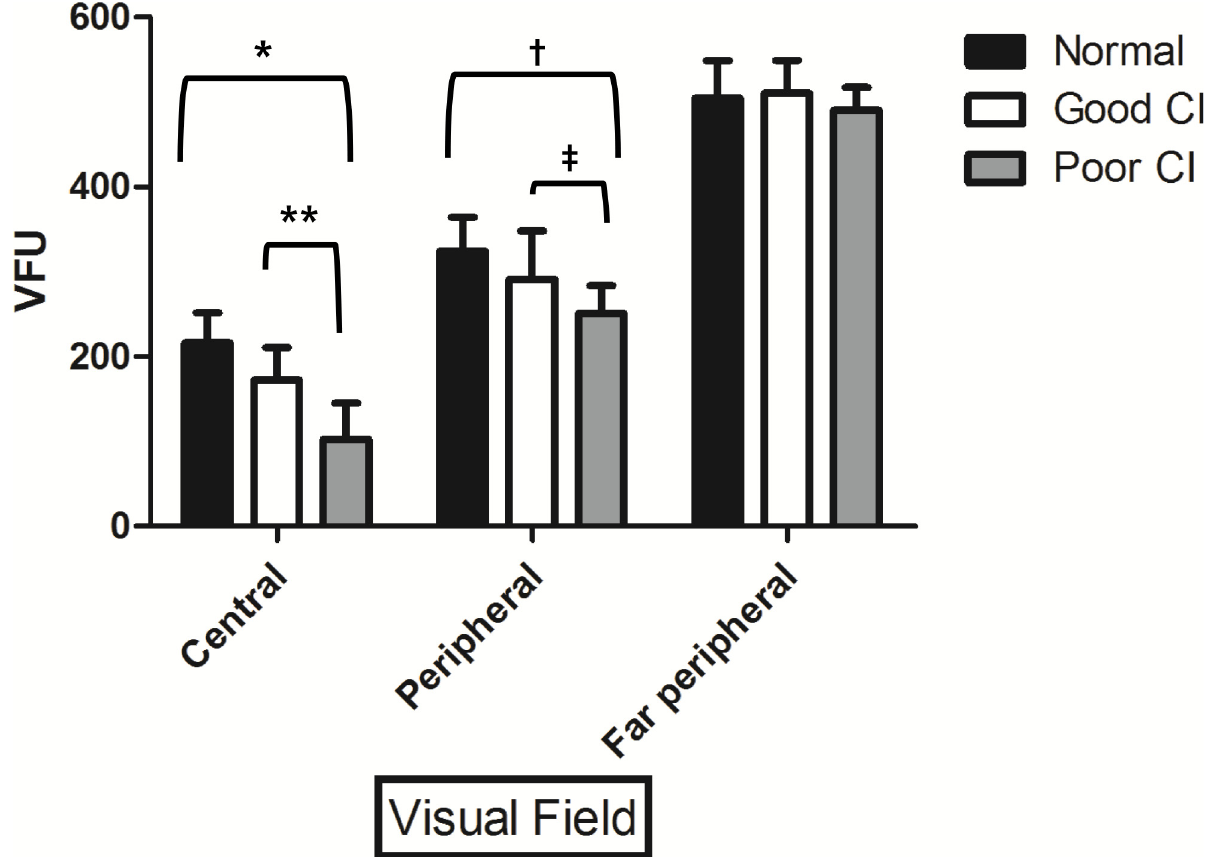
Fig 6. Visual Field Unit (VFU) difference in three groups by Goldmann perimetry. Based on results of Goldmann perimetry, central visual field was significantly narrowed in the poor CI performer group compared to the control and the good CI performer group. ( * ; P < 0.001 and ** ; P = 0.021, Mann- Whitney test) Peripheral visual field was also narrowed in the poor CI performer group compared to the control but not narrowed compared to the good CI performer group. ( † ; P = 0.014 and ‡ ; P = 0.107) However, far peripheral visual field was not different among the three groups.